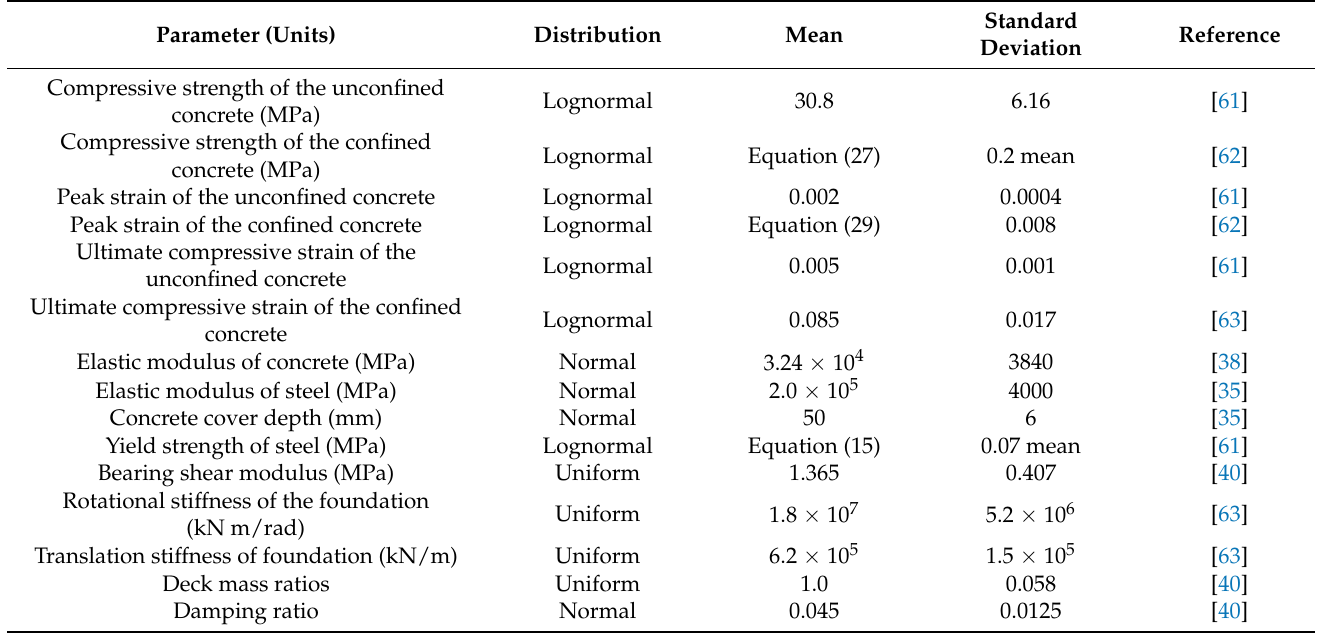
Table 3. Statistical information of the random variables considered in the FE modeling of the case- study